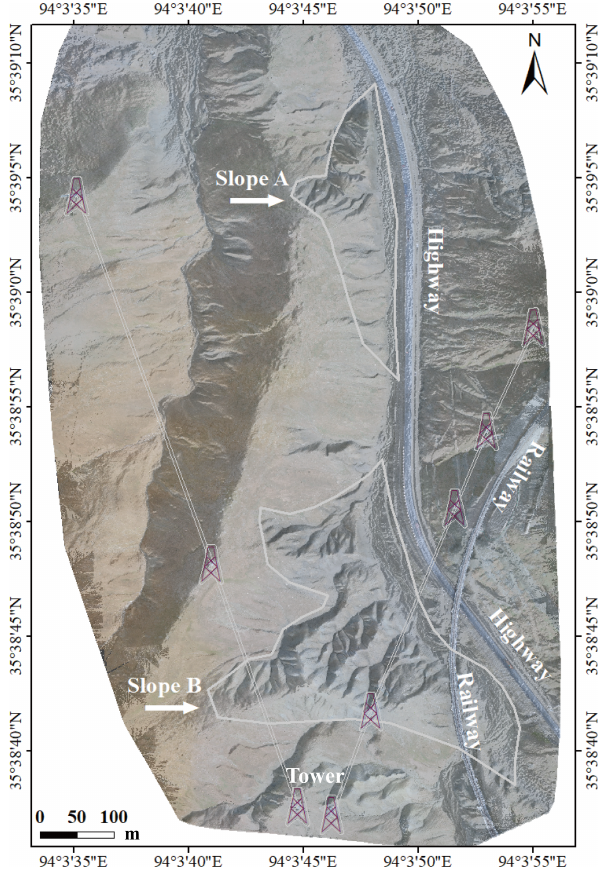
Figure 1. Geography of the study area, including the two per- mafrost slopes A and B, the Qinghai–Tibet Highway and Qinghai– Tibet Railway, and power and communication towers.